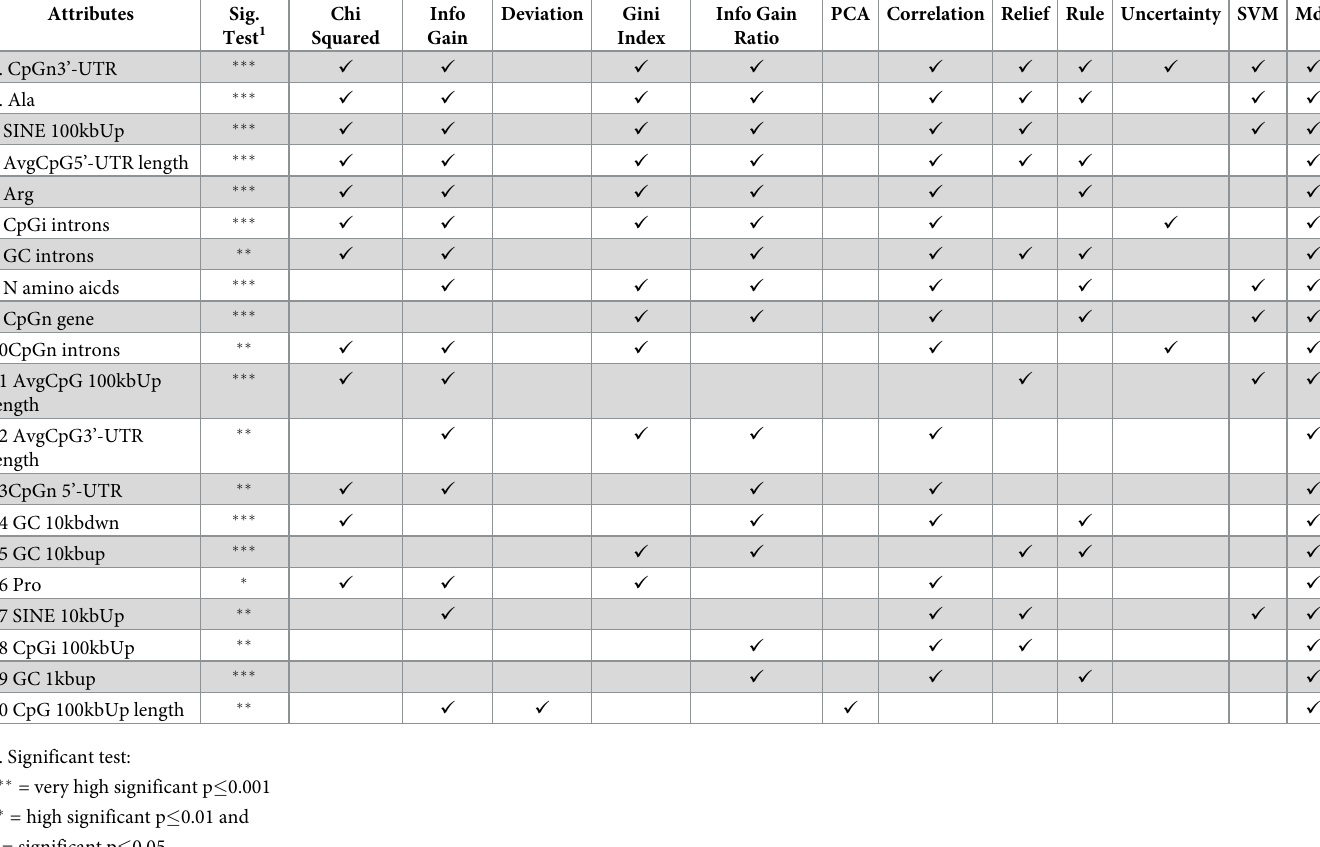
Table 2. The most important attributes selected by different attribute weighting algorithms. Attributes Sig. Test